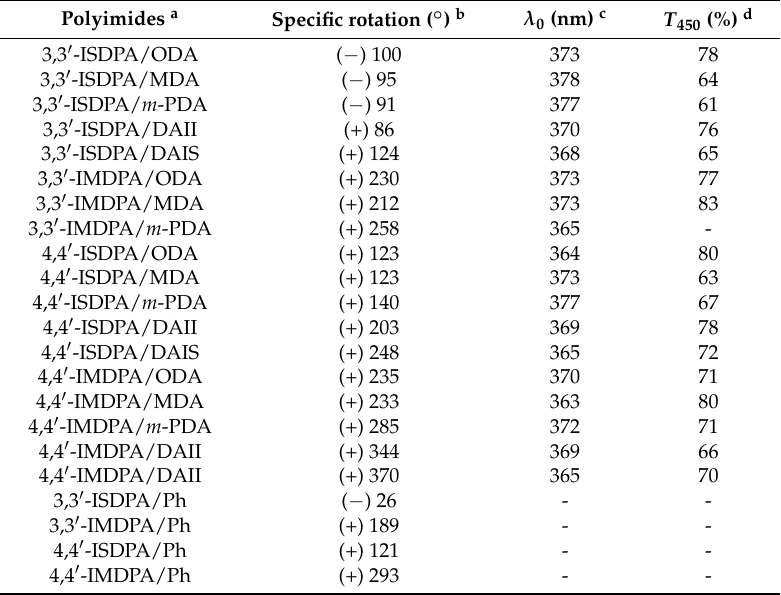
Figure 8. Representative UV-vis spectra of isohexides-derived PEIs (film thickness: 20 μ m). Table 3. Optical properties of isohexide-derived